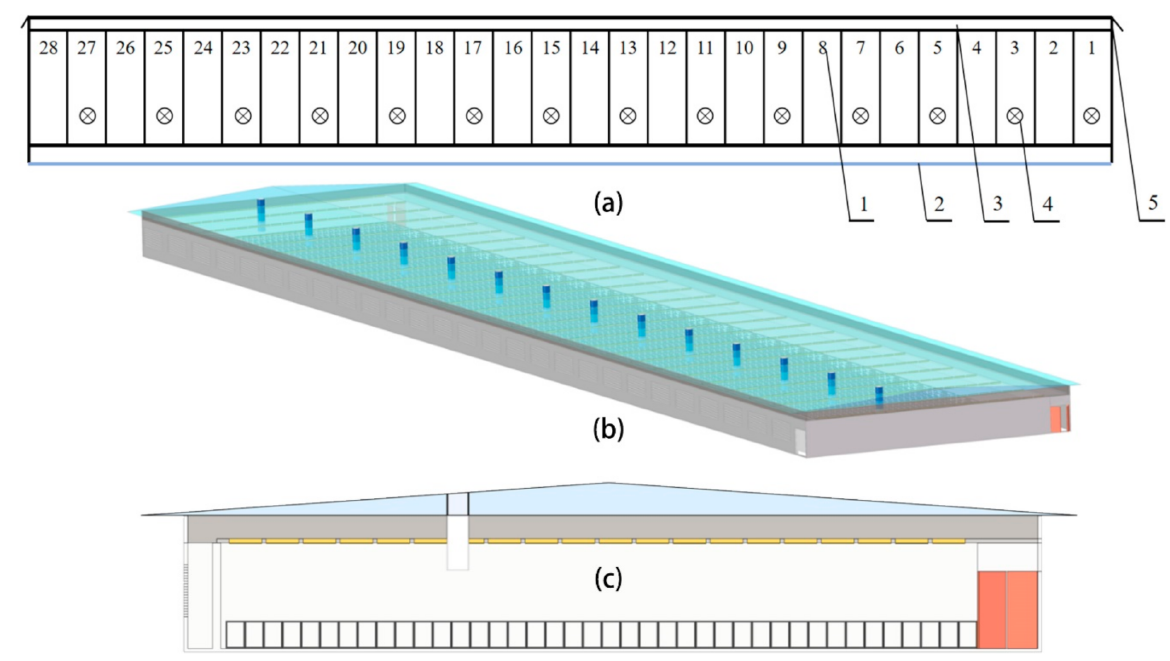
Figure 2. Pig housing in the study: ( a ) schematic model; ( b ) the three-dimensional model; ( c ) side view. 1 Number of the gestation house unit, 2 wet curtain, 3 walkway, 4 frequency conversion fan, 5